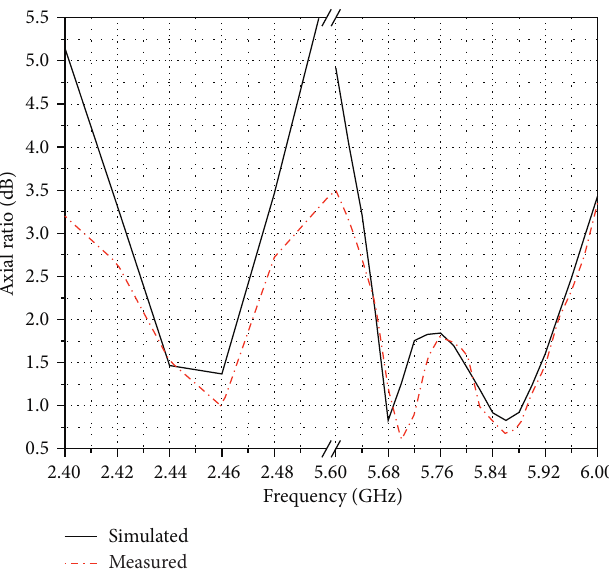
Figure 8: Simulated and measured axial ratio (AR).